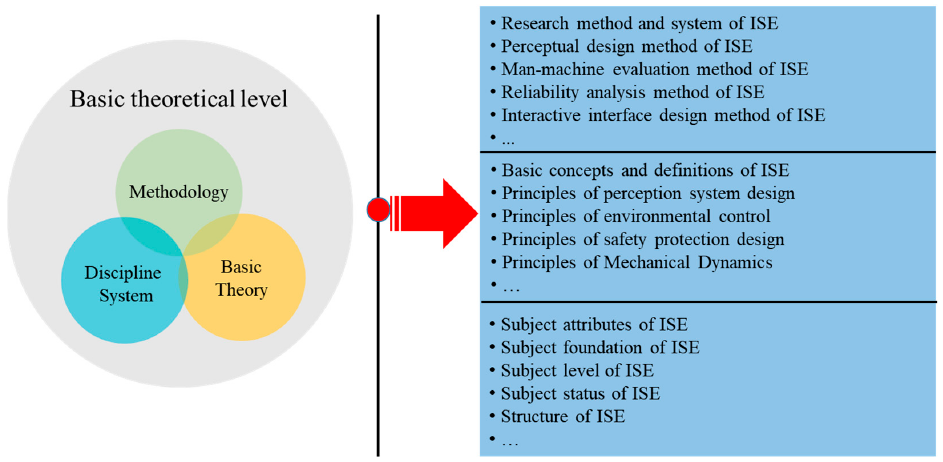
Figure 5. Basic theoretical level of ISE. Basic theory mainly includes three parts: methodology, basic theory, and subject system. theory, and subject